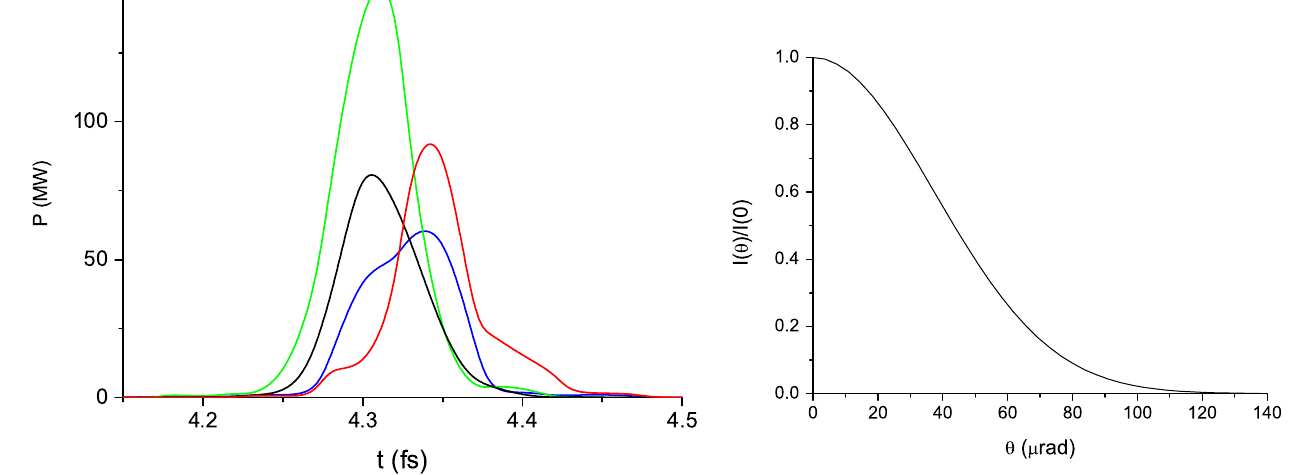
FIG. 11. The results of simulations of the radiation process in the last undulator with the code FAST when the undulator is tuned to 5 nm. Left: different realizations of attosecond pulses. Amplification in LSCAwas simulated with ASTRA (black) and LOSCA (red, blue, and green). Right: intensity distribution in far